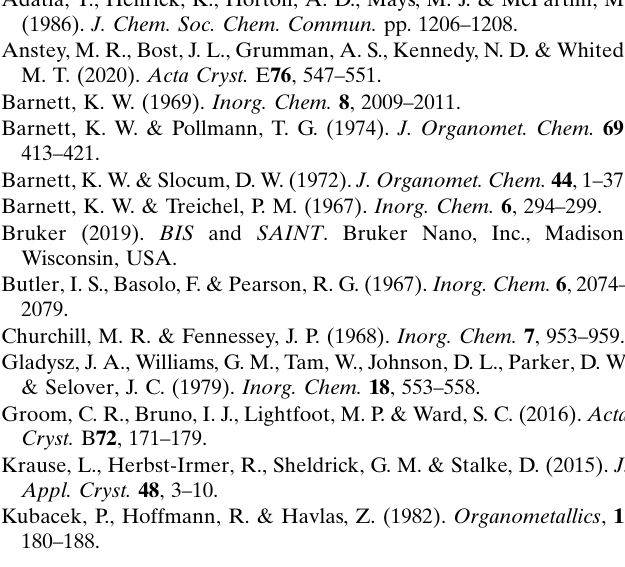
Crystal data Chemical